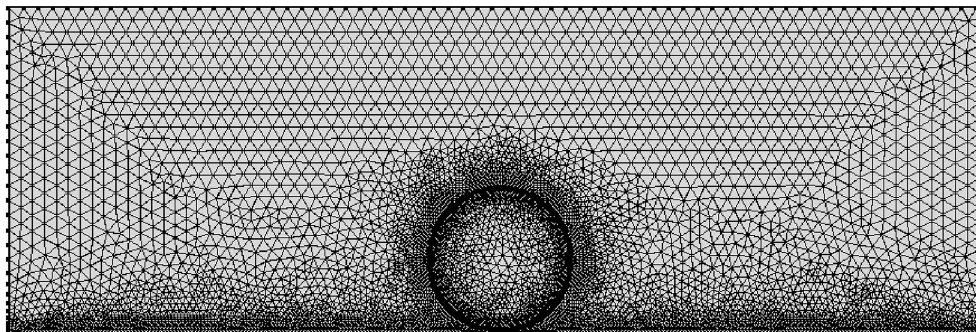
Figure 9. Generated mesh of the model.